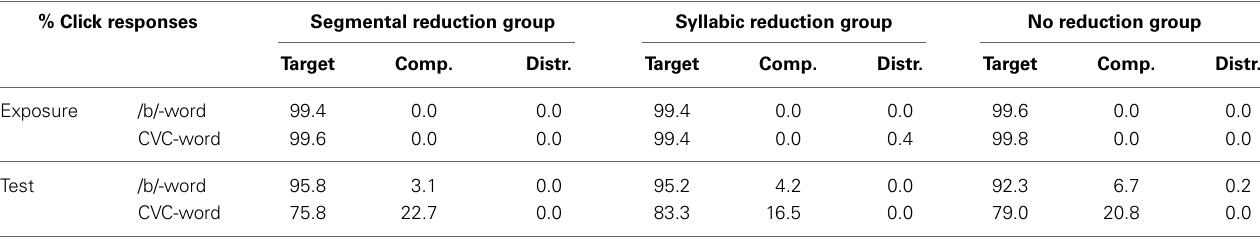
Table 4 | Accuracy data of the exposure and test phases of Experiment 3.